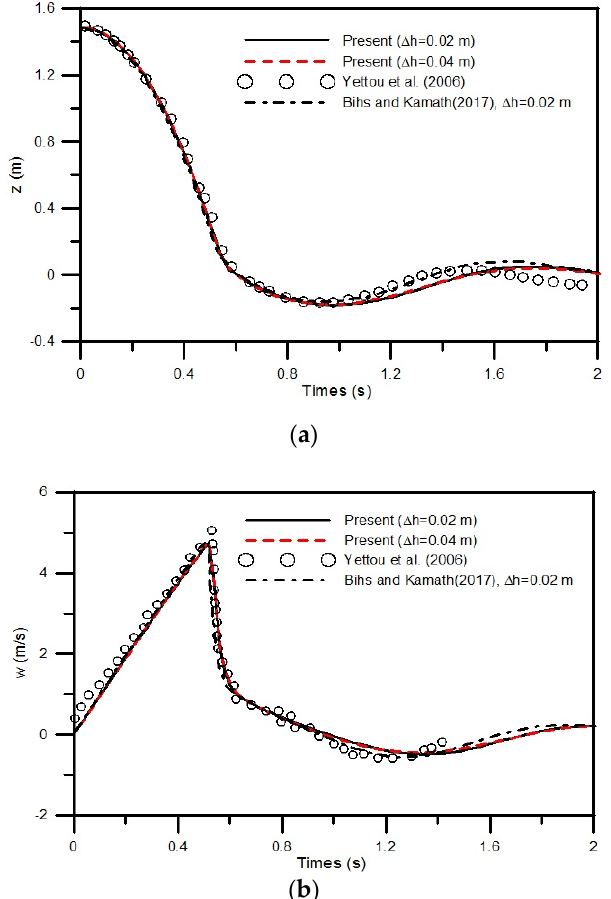
Figure 19. Motion of a free-falling wedge: ( a ) vertical position of the bottom vertex; ( b ) vertical velocity of the bottom vertex.